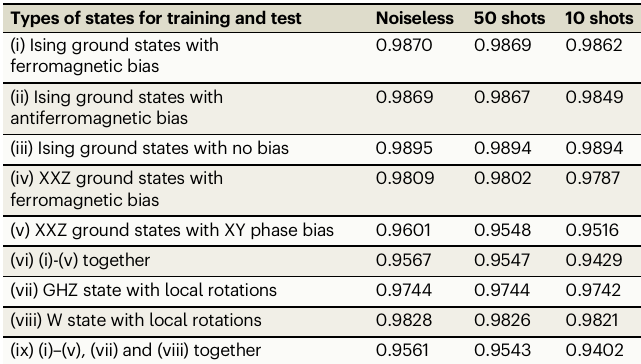
Table 1 | Average classical fi delities between the predictions of GQNQs and the ground truths with respect to different types of six-qubit states Types of states for training and